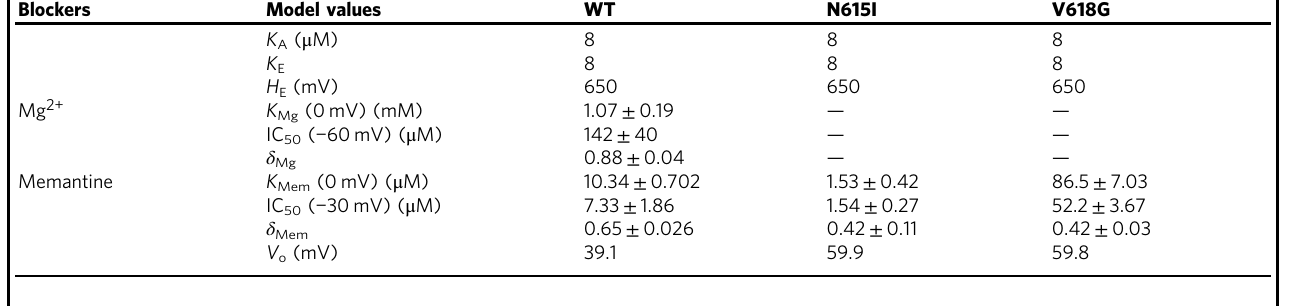
Table 2 Trapping block model parameters